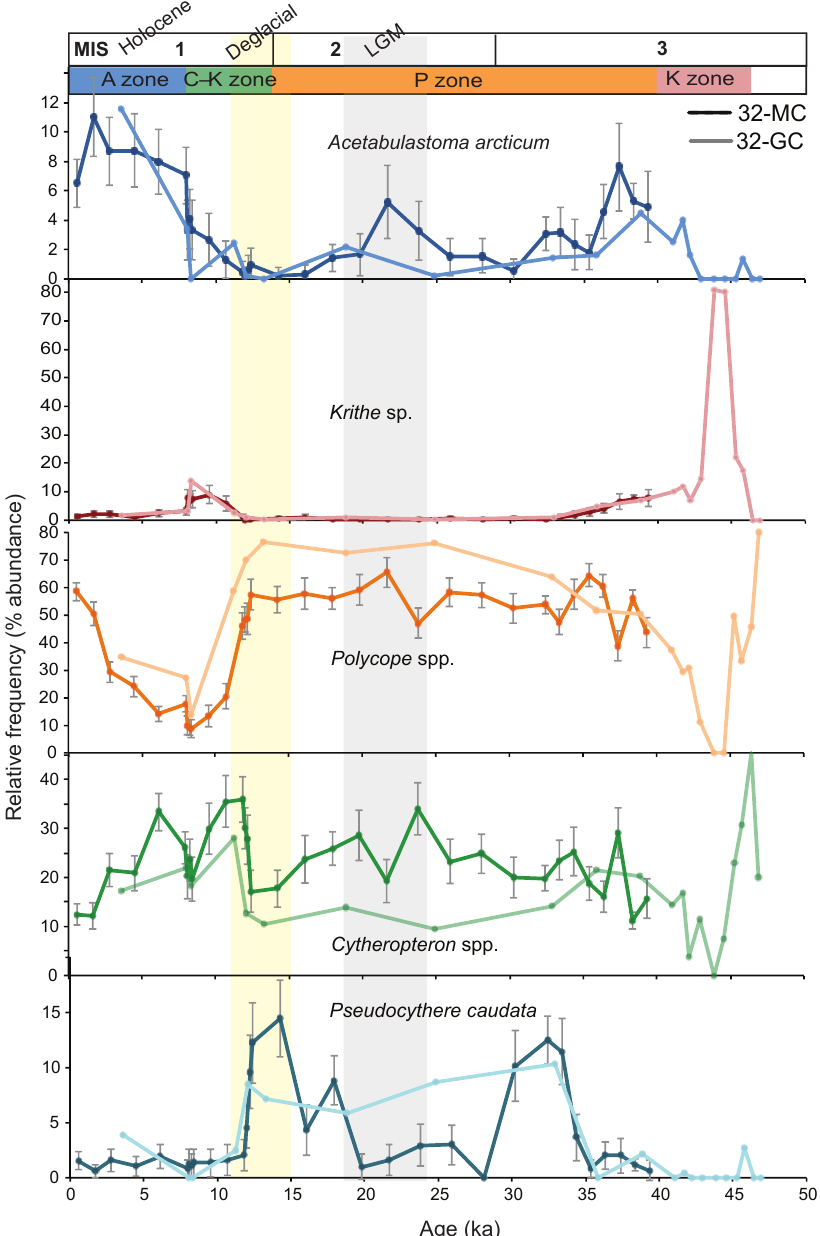
Figure 3. Relative frequencies (percent abundance) of dominant taxa in SWERUS-C3 32-MC and 32-GC. The y axis shows the modeled, mean age during a 2 σ range of